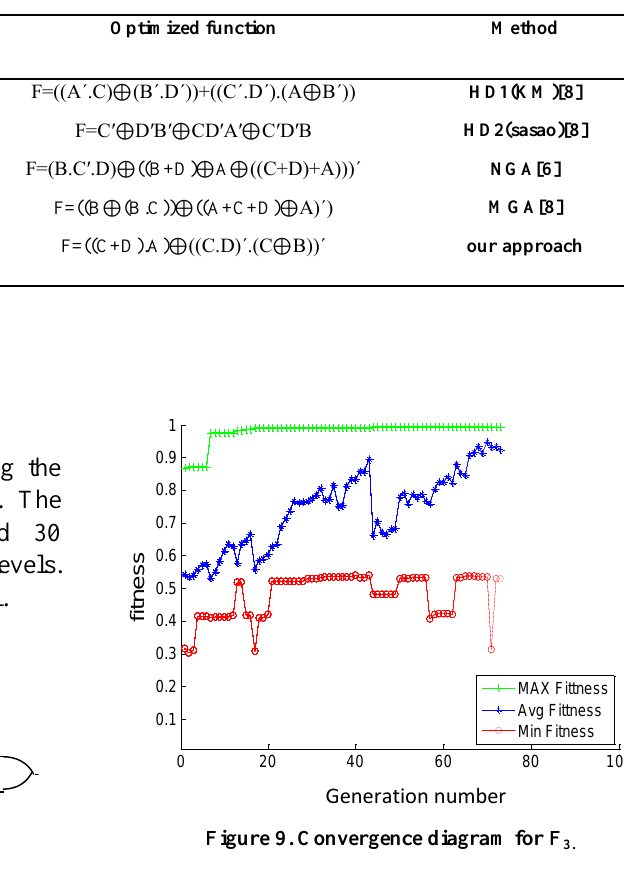
Method Optimized function Number